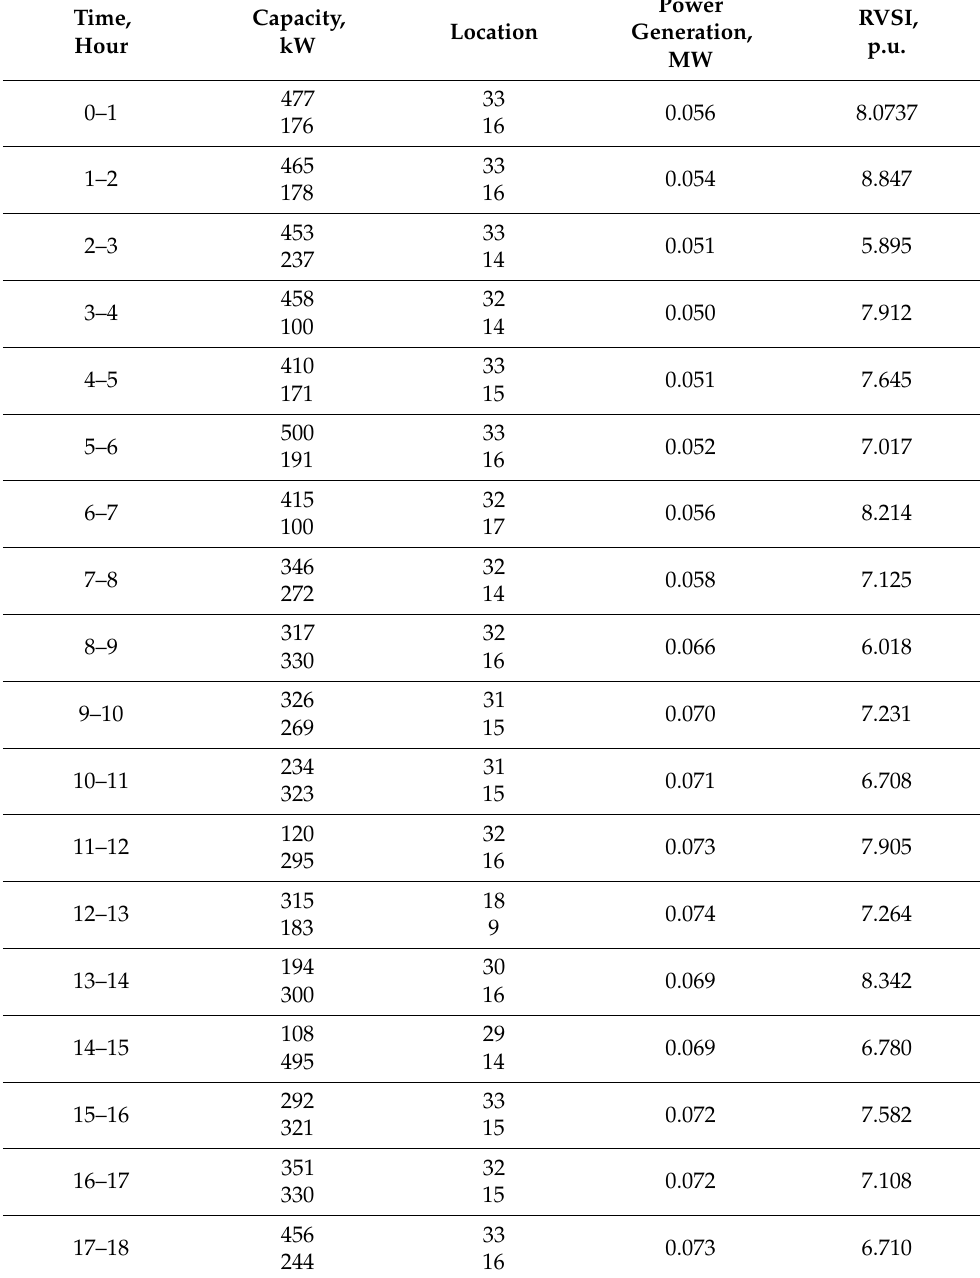
Table 8. Final capacity and location of BESS per hour (two BESSs